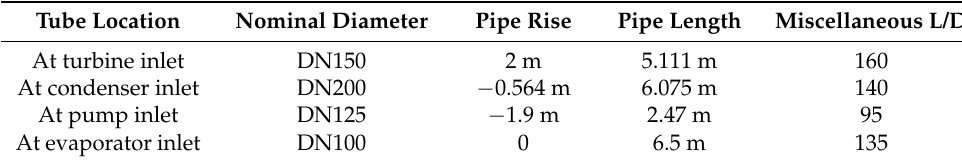
Table 2. Detailed information for the pipe system.